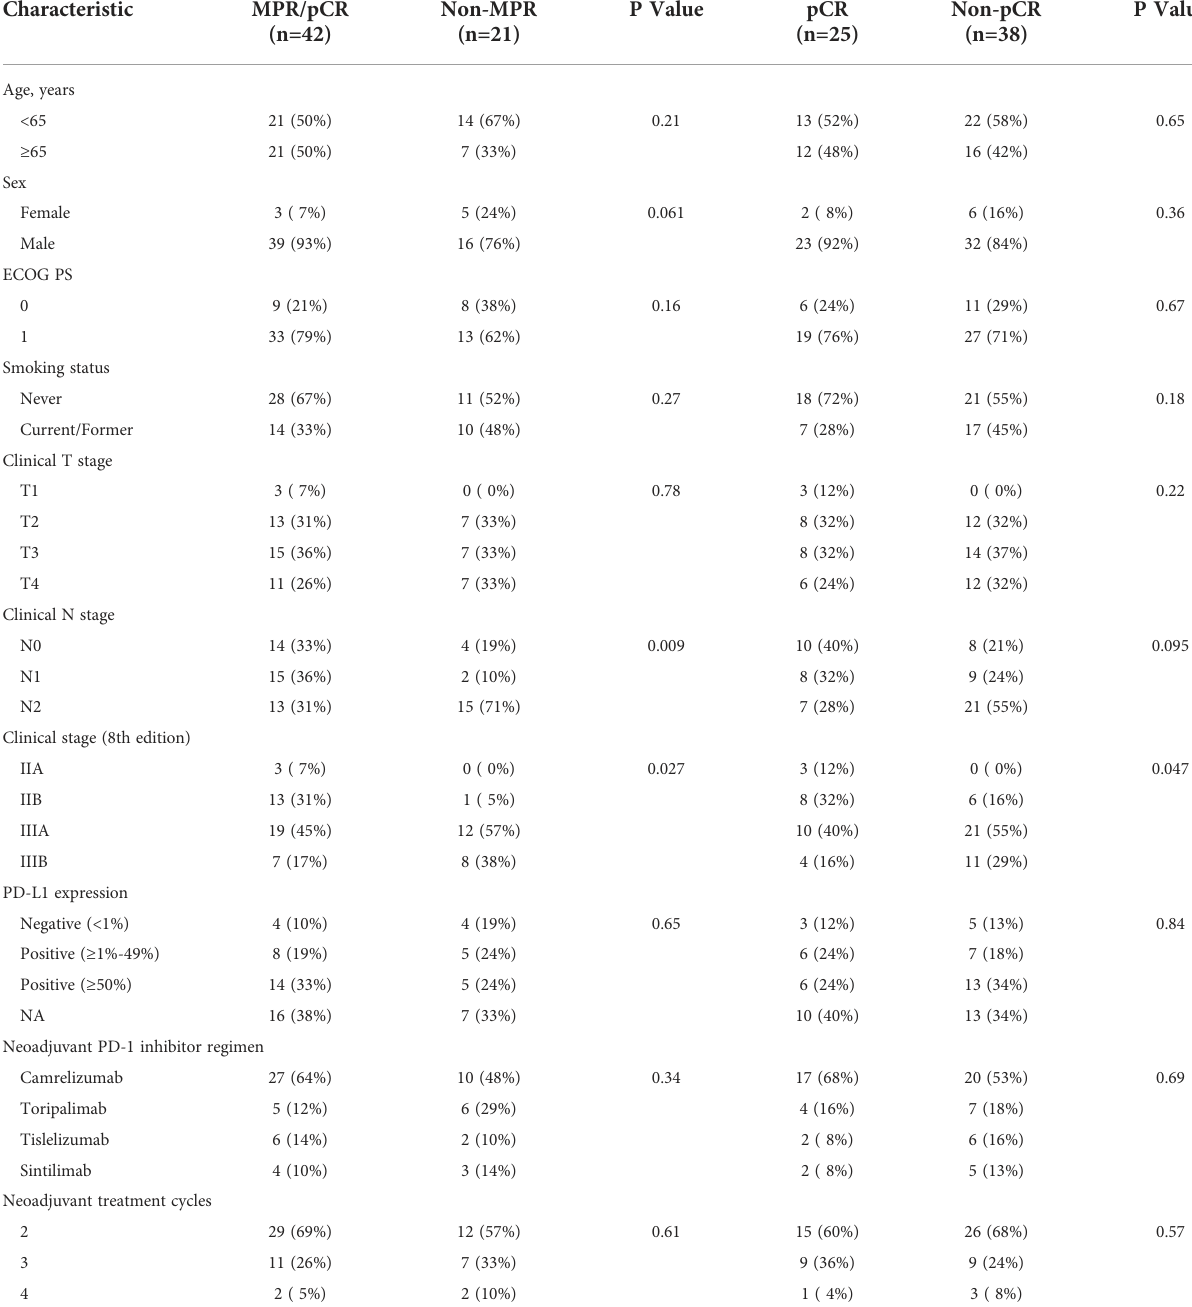
TABLE 3 Association between clinical characteristics and pathological